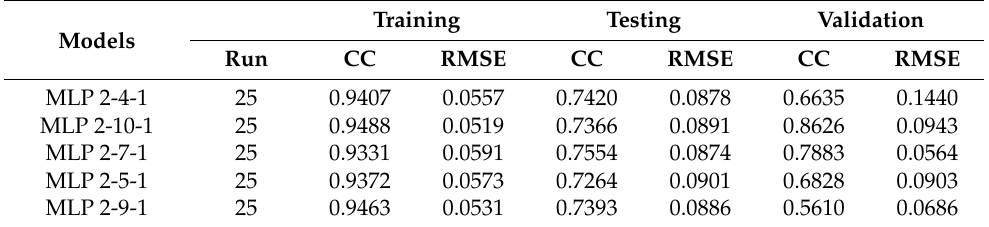
Figure 6. Scatter plot of target vs. output Cu employing numerous neural network models based on MLP in validation stage. MLP in validation stage. Table 3. Correlation coefficient and RMSE values for different MLP topologies in all stages for Cu.